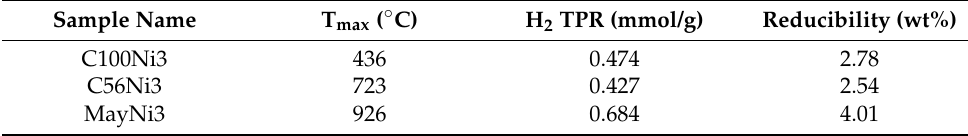
Figure 4. TPR profiles of (a) C100Ni3, (b) C56Ni3, and (c) MayNi3. Table 7. Temperature of the maximum reduction peak, H 2 consumption and reducibility.